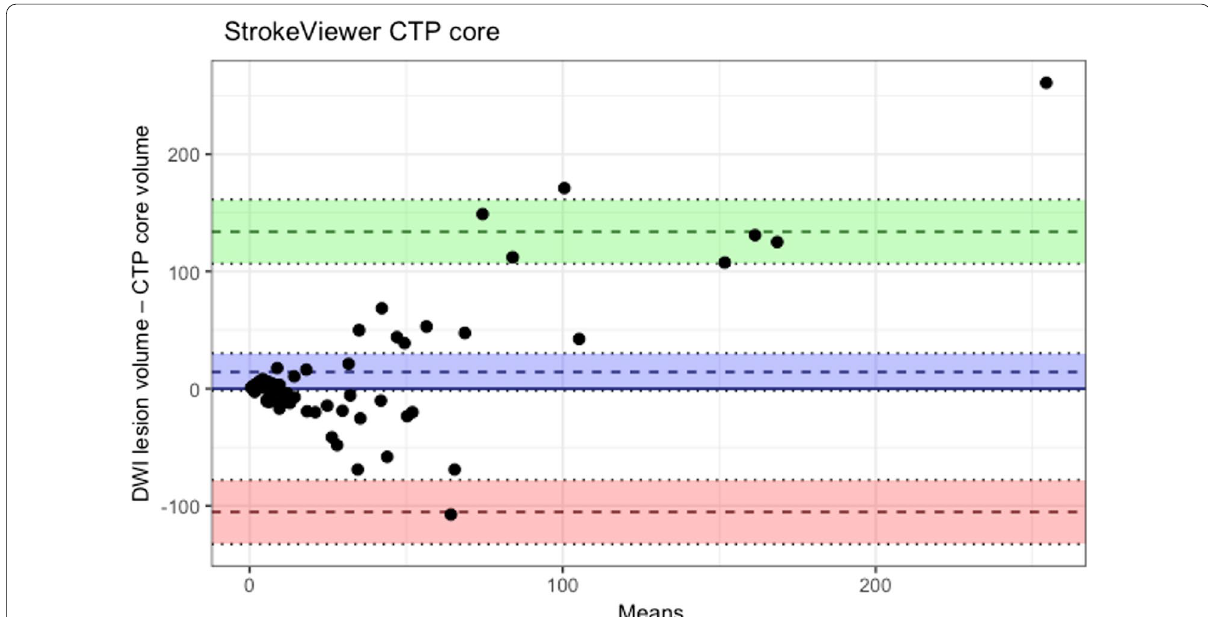
Fig. 2 Bland–Altman plot comparing the estimated CTP ischemic core volume and DWI follow-up infarct volume. The mean bias (blue), lower (red) and upper (green) limits of agreement are shown with 95% confidence intervals. The bias with 95% confidence intervals is shown in blue. Negative values indicate overestimation by CTP. CTP CT perfusion, DWI diffusion weighted